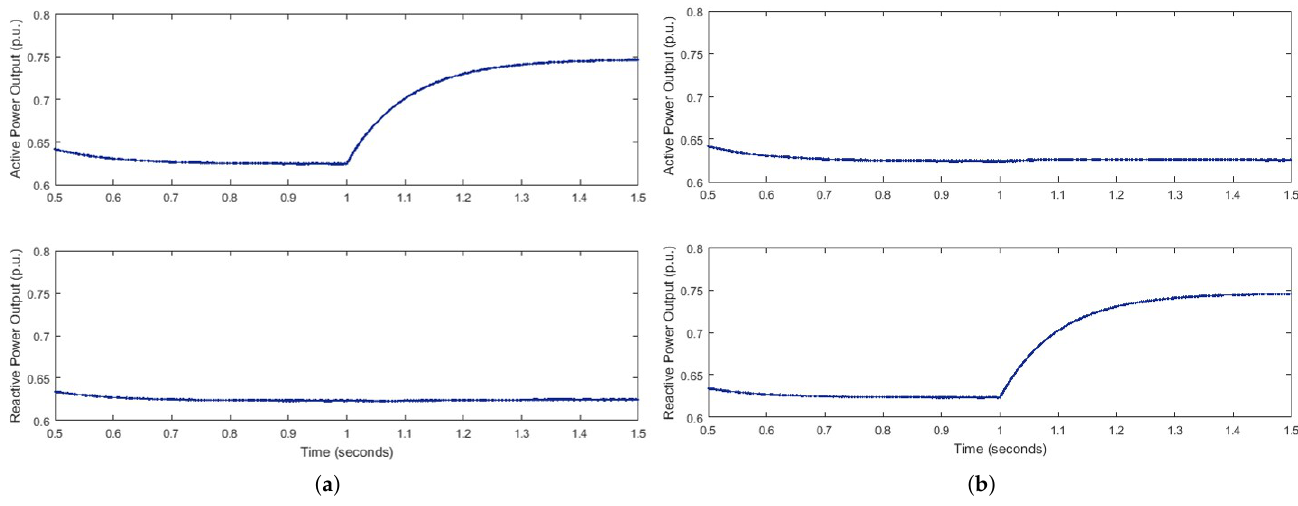
Figure 13. Simulation results to examine d-q coupling in the AC output of droop-controlled inverter. ( a ) Change in reactive power when active power is increased, ( b ) Change in active power when reactive power is